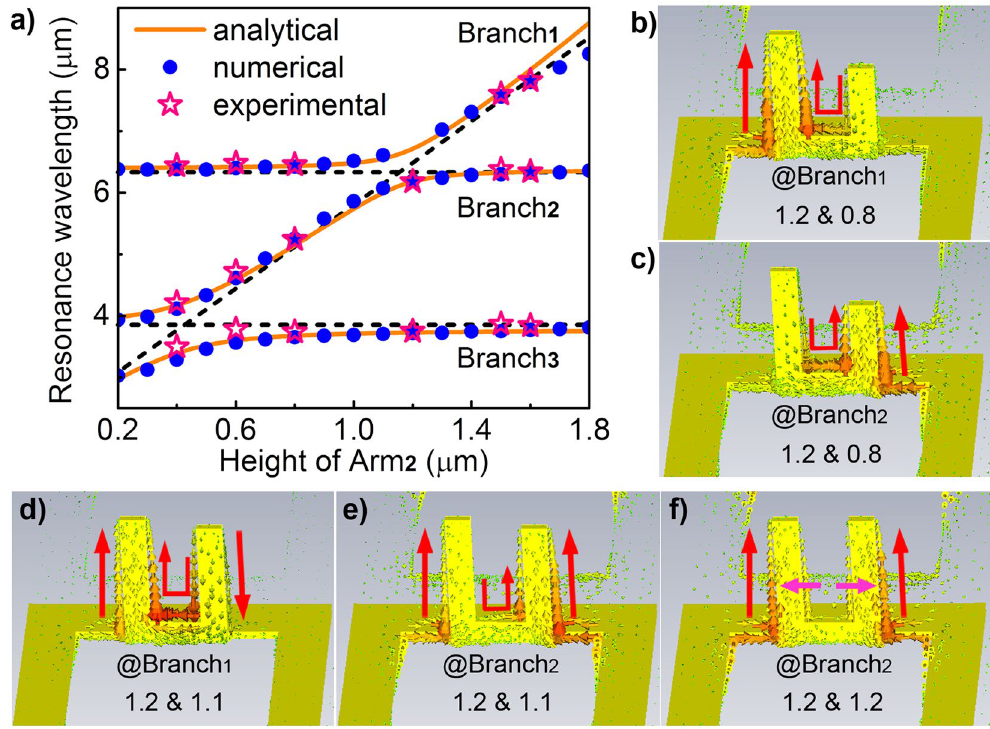
Figure 4. Analysis and discussions. ( a ) Relationship between the resonance wavelength and the height of Arm 2 under numerical simulations (blue dots), analytical calculations (orange lines), and experimental measurements (red stars). H Arm1 = 1.2 µ m. ( b , c ) Simulated current distributions of the aSRRs with H Arm1 = 1.2 µ m and H Arm2 = 0.8 µ m at corresponding resonance wavelengths in ( b ) Branch 1 and ( c ) Branch 2 , respectively. It can be seen that in this structure Branch 1 resonance is mainly dependent on the current oscillation along Arm 1 (the current flow along Arm 2 is negligible) while Branch 2 resonance mainly relies on the current oscillation along Arm 2 (the current flow along Arm 1 is negligible), as schematically noted by the red arrows. ( d , e ) Simulated current distributions of the structure with H Arm1 = 1.2 µ m and H Arm2 = 1.1 µ m at corresponding resonance wavelengths in ( b ) Branch 1 and ( c ) Branch 2 , respectively. It can be seen that in the anticrossing region both arms of the SRRs take part in electric current interaction through the circular current flows. ( f ) Simulated current distributions of the structure with H Arm1 = H Arm2 = 1.2 µ m at the Branch 2 resonance wavelength (the Branch 1 resonance exhibits a singularity as in Fig. 2c,d). It can be seen that the current flows along the two arms are identical and are repelled towards the edges of the SRR arms due to charge repulsion by Coulomb